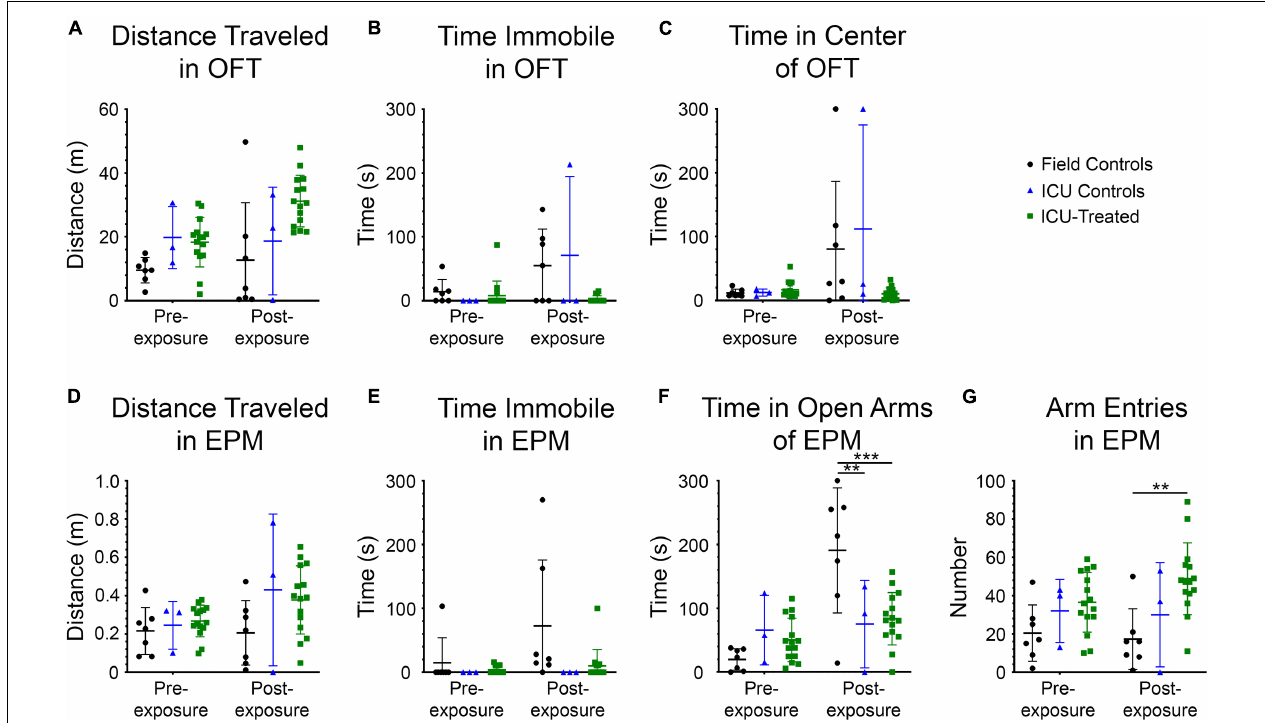
FIGURE 5 | Performance in the open field test (OFT) and elevated plus maze (EPM) for each treatment group before and 9 days after NA exposure. All metrics were evaluated using 2 × 3 way repeated-measures ANOVAs with Sidak’s multiple comparison tests to compare field controls ( n = 7), ICU controls ( n = 3), and ICU-treated rats ( n = 15) at each testing time point. Significant main effects and interactions are reported in the Results section. For the OFT, there were no pairwise differences between treatment groups at either time point for (A) total distance traveled, (B) time spent immobile, or (C) time spent in the center of the field. For the EPM, there were no pairwise differences between treatment groups at either time point for (D) distance traveled or (E) time spent immobile. (F) However, it was observed that there were significant pairwise differences in the amount of time spent in the open arms of the EPM, with field controls spending more time in the open arms than ICU controls and ICU-treated rats post-exposure (** p < 0.01,*** p < 0.001). (G) Additionally, there were significant pairwise differences in the number of entries into any arm of the EPM, with ICU-treated rats making more entries into arms post-exposure than field controls. This suggests that ICU-treated rats were more exploratory and displayed more typical inhibitory behavior than field controls post-exposure. For all panels, lines show mean values for each treatment group, and error bars show standard